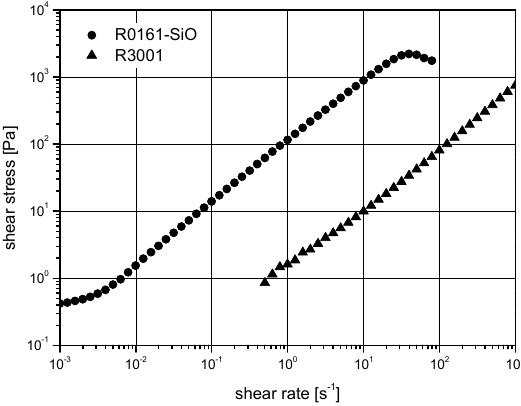
Figure 6 . Shear rate sweeps of category II Underfillers. Figure 6. Shear rate sweeps of category II